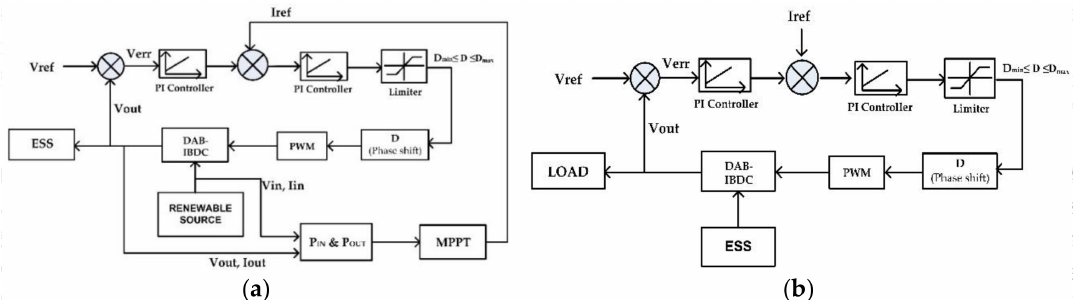
Figure 12. Digital control loop diagram for DAB-IBDC converter ( a ) Forward mode charging control loop with MPPT ( b ) Backward mode dis-charging control